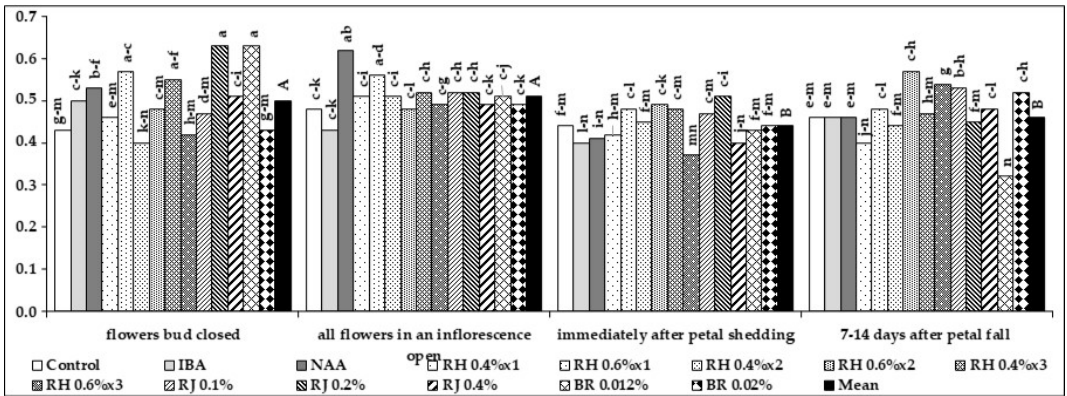
Figure 8. The influence of rooting enhancers on chlorophyll a content (mg g − 1 FW) in leaves of Rosa ‘Maiden’s Blush’ cuttings harvested from shoots in four phenological stages of shoots. Control—the control cuttings; IBA 0.4%—Ukorzeniacz A aqua (0.4% IBA); NAA 0.2%—Ukorzeniacz B aqua (0.2% NAA); RH 0.4% × 1, RH 0.6% × 1—watering with 0.4% or 0.6% Bio Rhizotonic (10 mL) after planting; RH 0.4% × 2, RH 0.6% × 2—watering with 0.4% or 0.6% Bio Rhizotonic (10 mL) after planting and 10 days later; RH 0.4 × 3, RH 0.6% × 3—watering with 0.6% Bio Rhizotonic (10 mL) after planting, 10 and 20 days later; RJ 0.1%, RJ 0.2%, RJ 0.4%—watering with 0.1%, 0.2%, or 0.4% Root Juice ™ (10 mL) after planting; BR 0.012%, BR 0.02%—watering with 0.012% or 0.02% Bio Roots (10 mL) after planting. Di ff erent small letters indicate significant interactions between phenological stage and treatment (two-way ANOVA). Di ff erent capital letters indicate significant di ff erences between phenological stages. The Duncan’s test ( α = 0.05) was used.